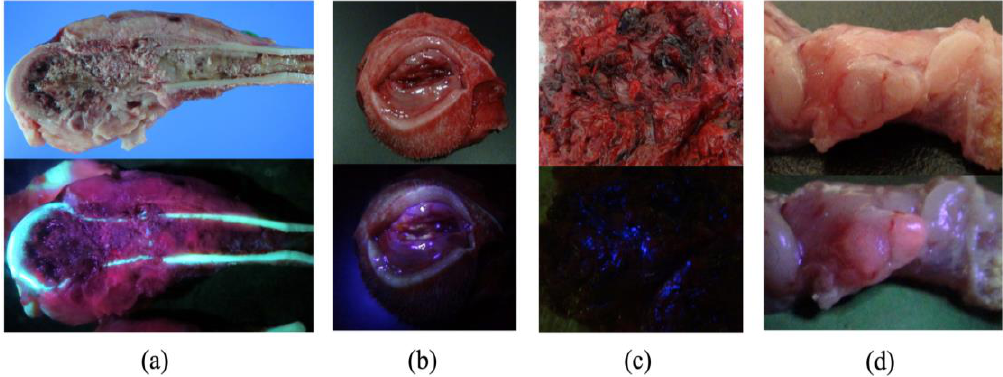
Figure 2. Representative images of photodynamic detection cases. The upper images comprise the white light images and the lower images are the fluorescence images. ( a ) Positive case of osteosarcoma of the distal femur. The red fluorescence at 635 nm is evident in the cancerous lesions but not in the necrotic tumor lesions. ( b ) Negative case of a subcutaneous granulomatous inflammation. Red fluorescence was not observed. ( c ) False-negative case of splenic hemangiosarcoma with a large quantity of blood. Although tumor cells were observed by histological examination, there was no peak for photosensitizer protoporphyrin IX (PpIX) in the fluorescence spectrum. ( d ) False-positive case of lymphatic follicles. The red fluorescence and follicles occur at the same location, which might be related to the infiltration of inflammatory cells.